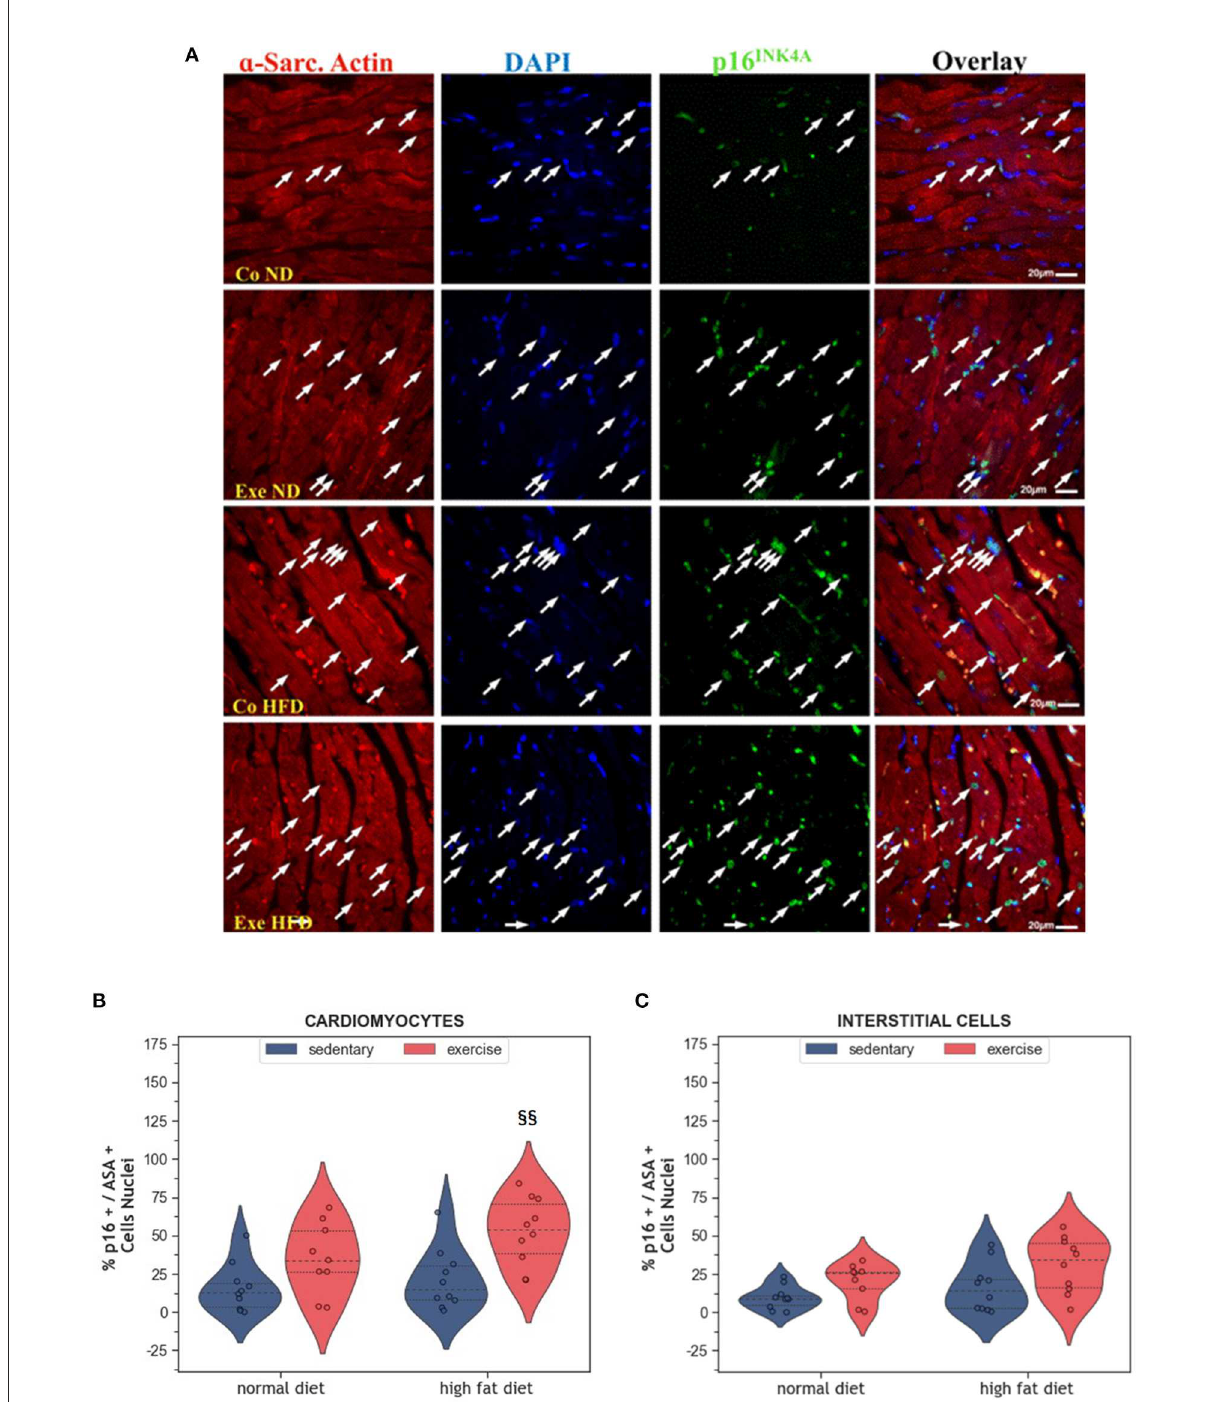
FIGURE4 (A) Representative histological images of the left ventricle showing an increased number of senescent cardiomyocytes in HFD groups. The sections were co-immunostained with an anti-p16 INK4A antibody, an anti-Sarcomeric alpha Actin (ASA) antibody, and DAPI. Arrows point to senescent nuclei. (B) Violin plot showing the left ventricular fraction of Sarcomeric alpha-actin positive cardiomyocytes that are also p16 INK4A positive. (C) Violin plot showing the fraction of Sarcomeric alpha-actin negative p16 INK4A positive interstitial cells. From each experimental group 10 animals were selected for histomorphometry analysis. Statistical differences between groups were calculated with the two-way ANOVA with Sidak post-hoc tests for multiple comparisons. p -values are only shown for pre-specified group comparisons. §§ p < 0.01 compared to the high fat diet sedentary control